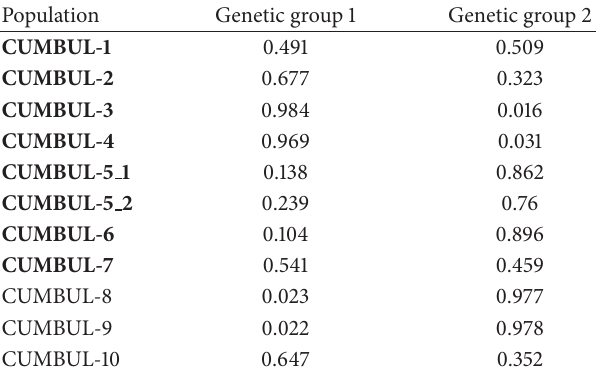
Table 3: Proportion of membership of each Bulgarian Orobanche cumana population in inferred STRUCTURE groups for 𝐾 = 2 . Populations collected on wild hosts are highlighted in